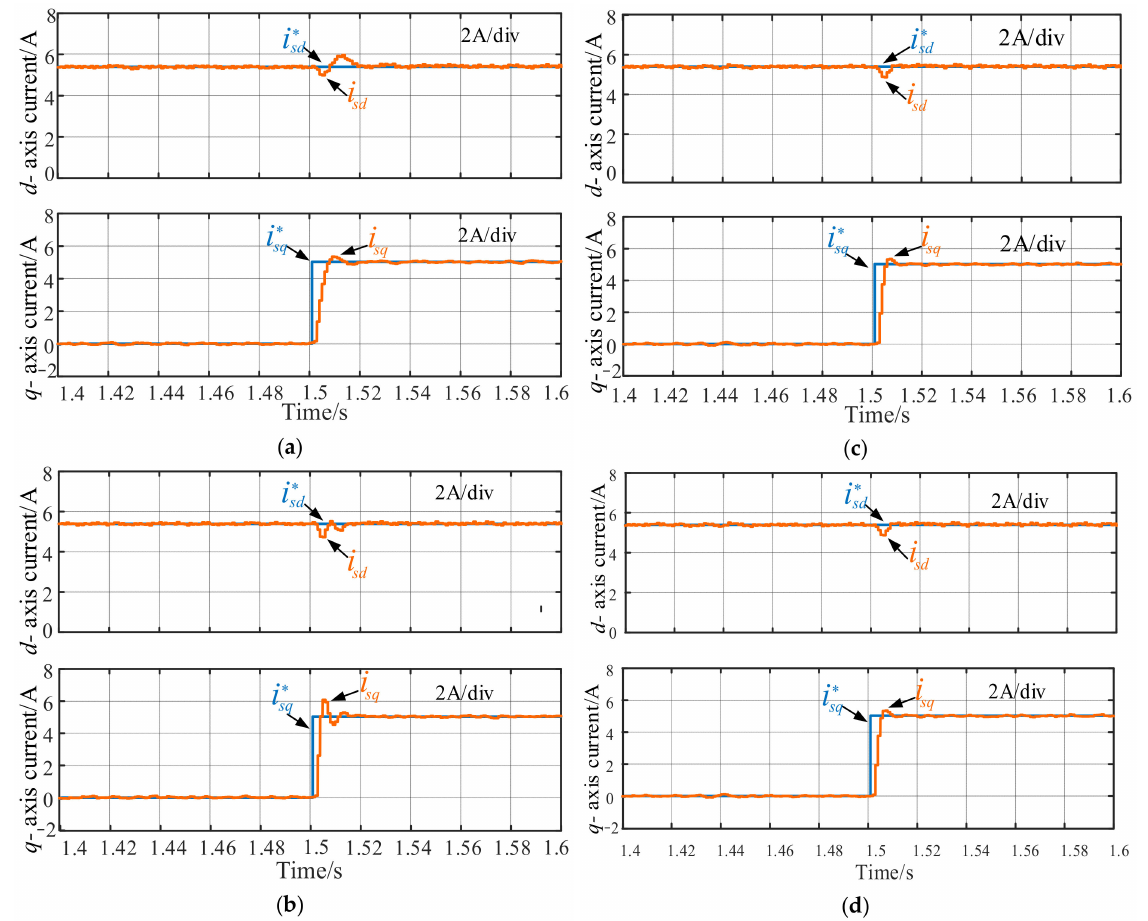
Figure 21. dq -axis current response of improved complex vector controller with parameter estimation error: ( a ) ˆ σ ˆ L s = 0.6 σ L s ;